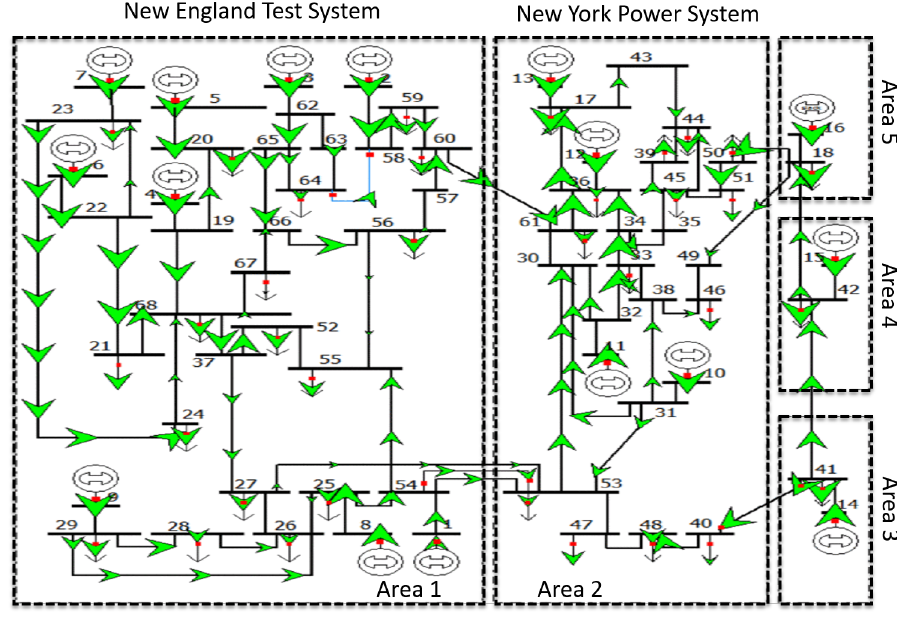
Figure 3. IEEE 68-bus system test simulation